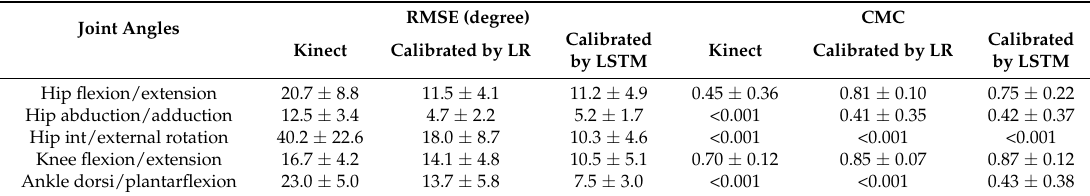
Figure 1. The average hip, knee, and ankle angles during a gait cycle across all gait trials. Table 3. Root mean square error (RMSE), coefficients of multiple correlation (CMC) ( ± SD) between the joint angle trajectories, using Kinect, Kinect calibrated by linear regression (LR) and long short-term memory (LSTM) recurrent neural network, and Motion